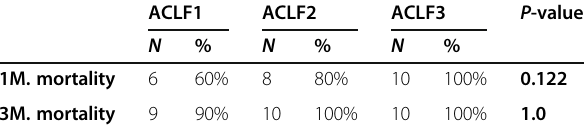
Table 8 Mortality between 3 ACLF groups in